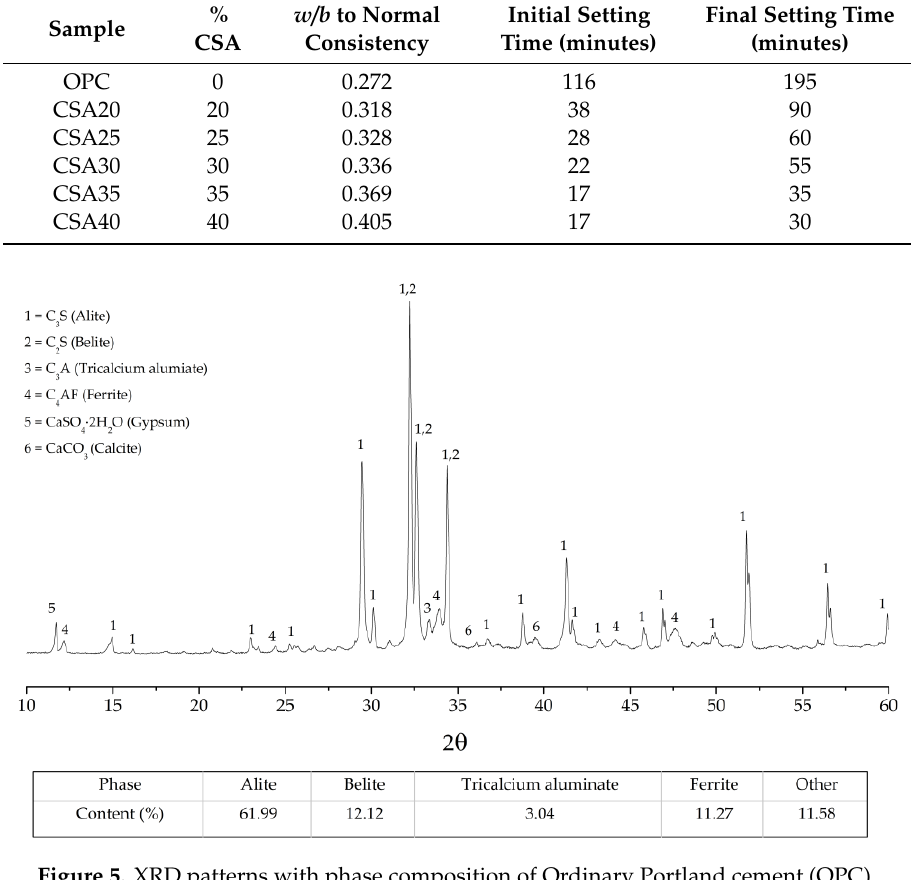
Table 5. Compressive strength of cement pastes at di ff erent curing